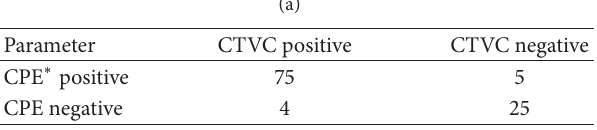
∗ CPE: cystopanendoscopic examination was taken as reference standard and CTVC: computed tomography virtual cystoscopy.